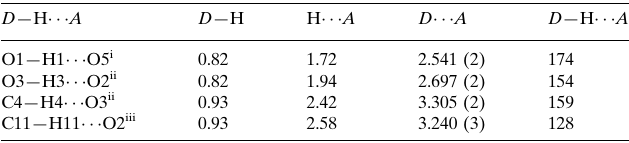
hydrogen-bonding interactions, forming chains propagating in [210].